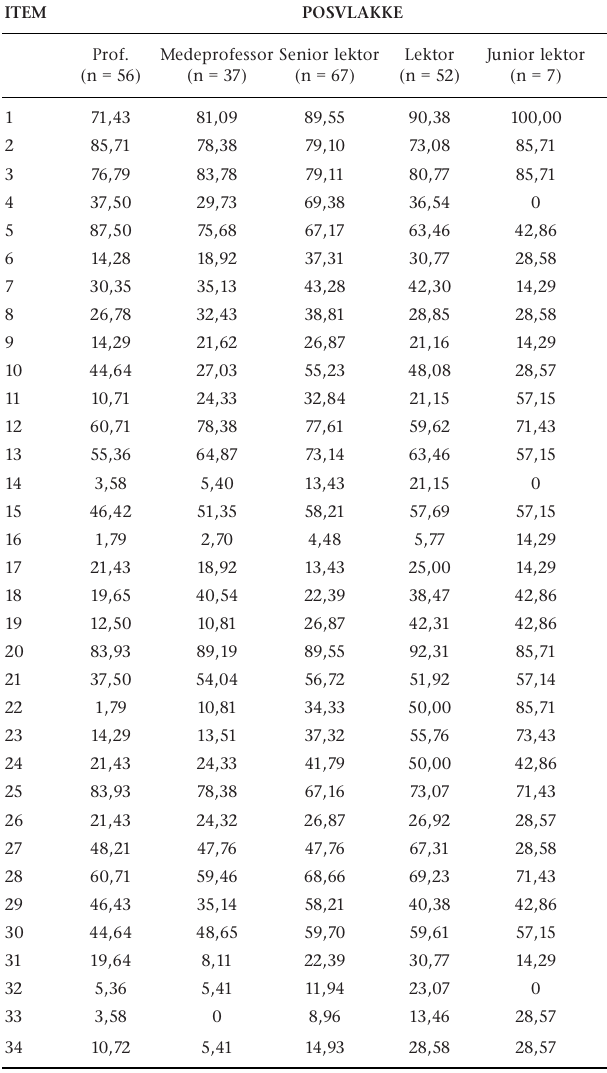
groep wat belemmering ervaar omdat hulle beleef dat hulle meer by buitewerk of klasgee baat vind, en dat hulle meer tyd en energie aan buite-inkomste moet bestee omdat